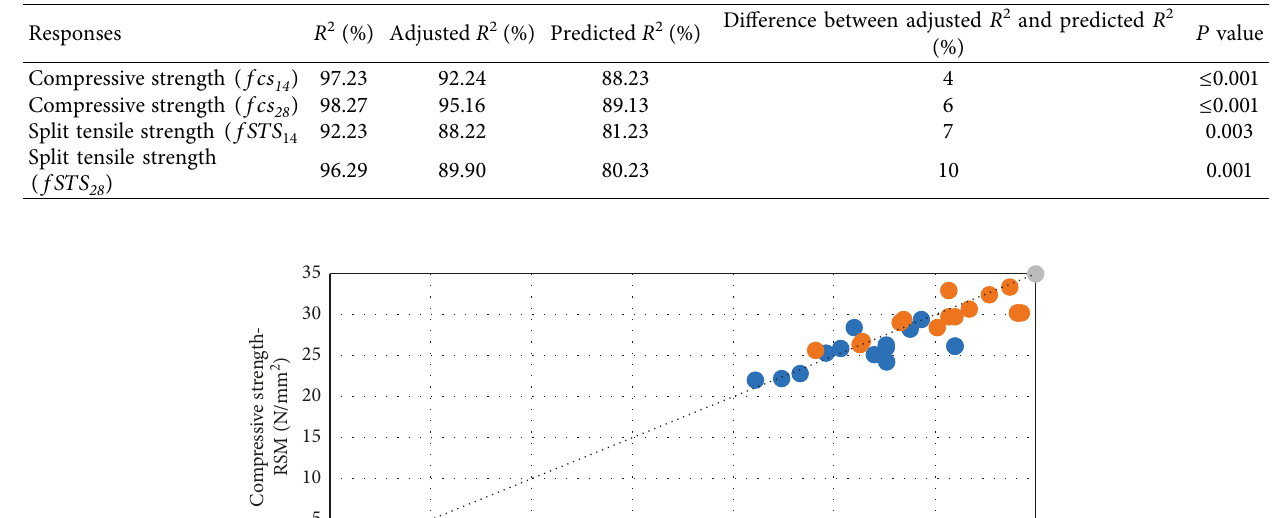
Table 6: Proportion of variance ( R 2 ) of the regression model.